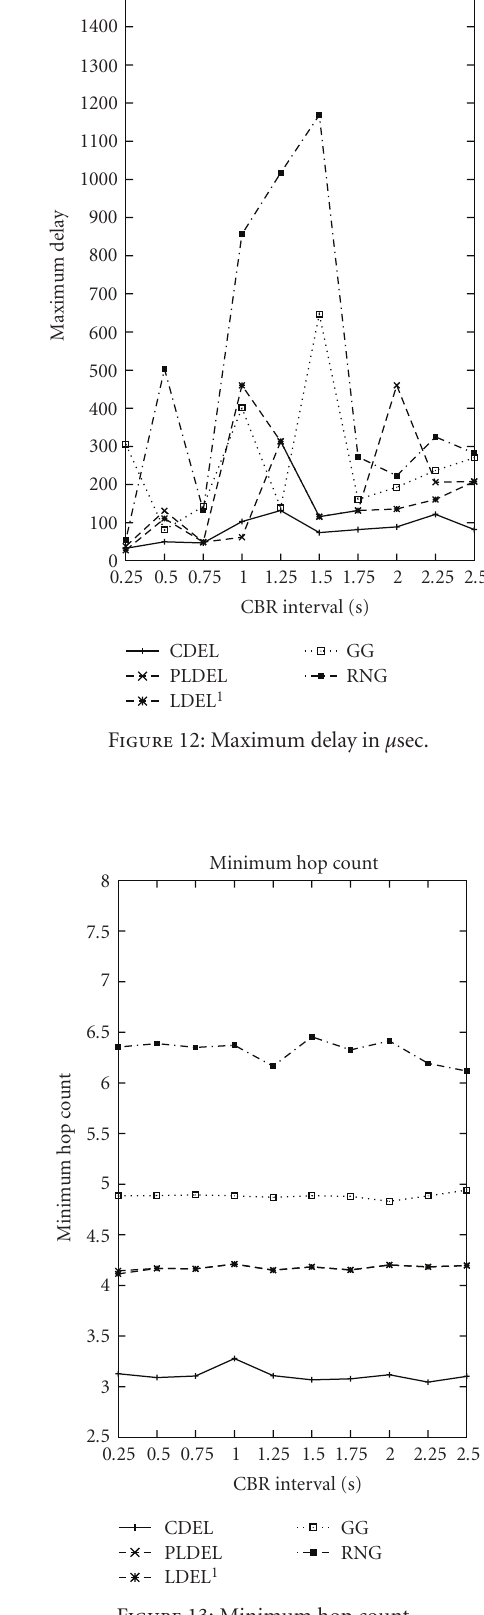
Figure 13: Minimum hop